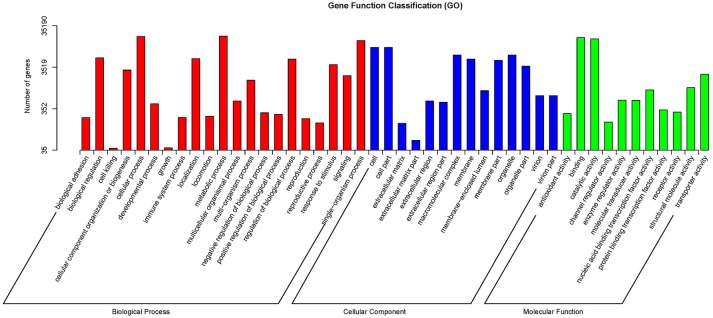
Gene ontology (GO) functional classification of unigenes.